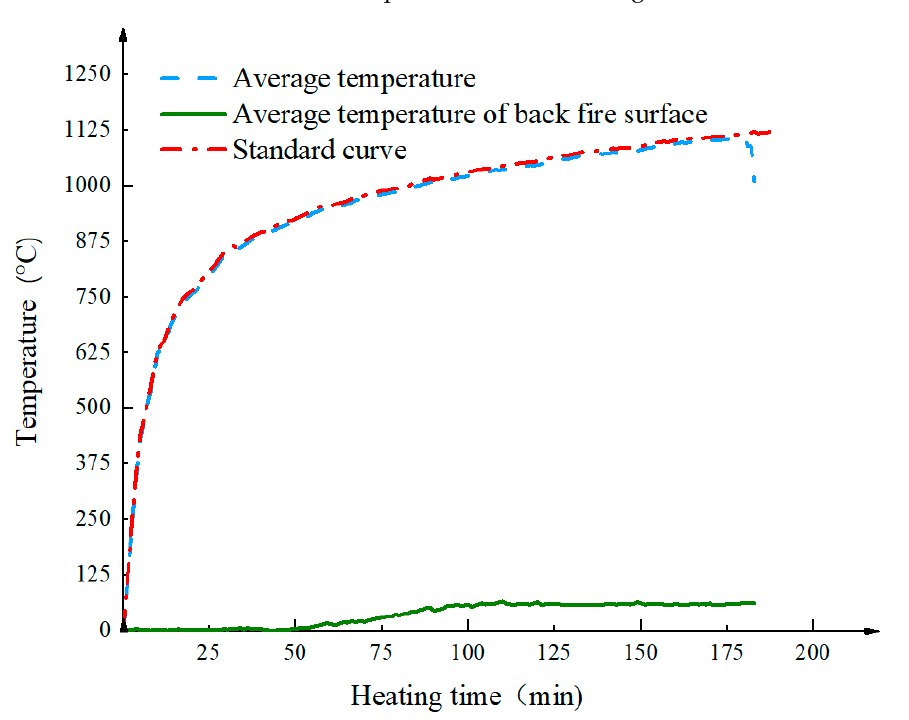
Figure 5. Temperature rise curve.